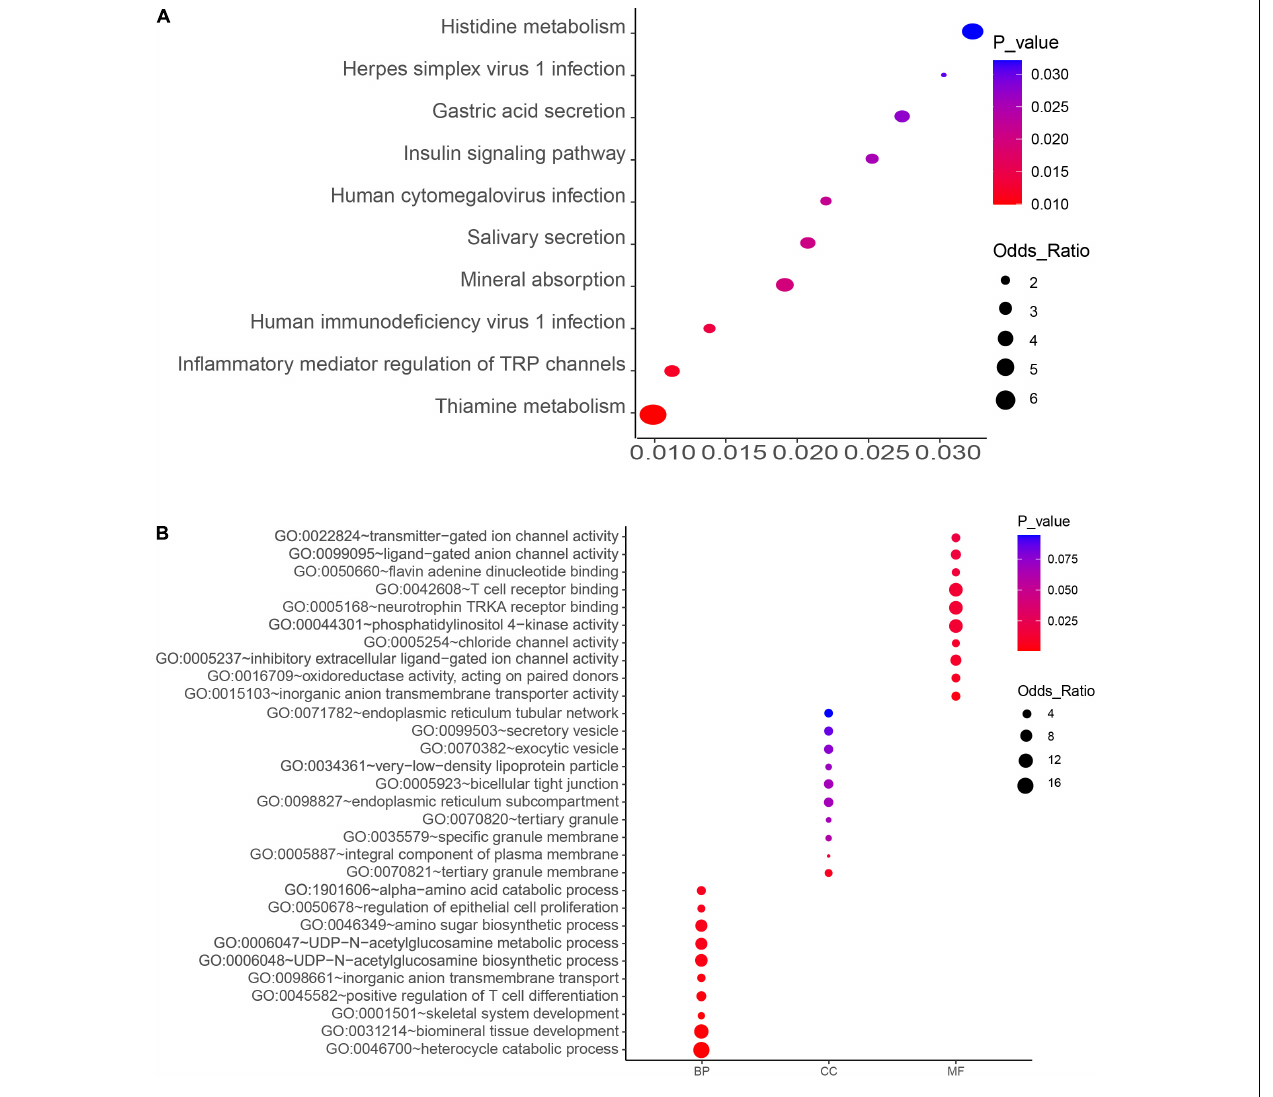
FIGURE 2 | KEGG pathway (A) and GO enrichment (B) analyses of the top-ranked PM 2 . 5 resistance genes with high number (4–6) of unique sgRNAs. Significant processes and pathways are depicted in red. BP, GO Biological Process; MF, GO Molecular Function; CC, GO Cellular